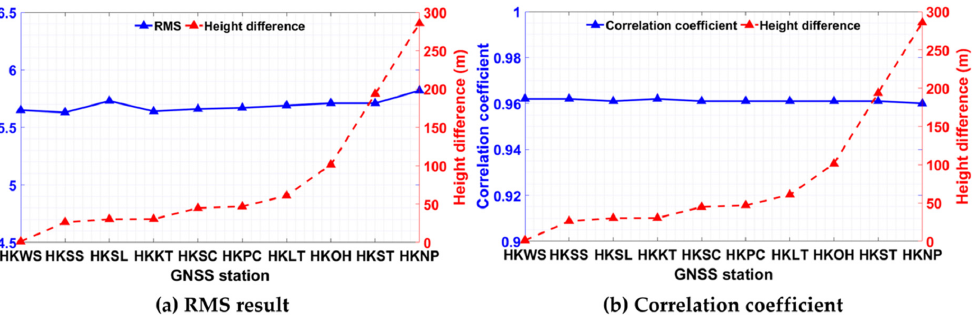
Figure 4. RMS ( a ) and correlation coefficient ( b ) results of calibrated TH-PETs at the KP station using the temperature, pressure, MJD, and ZTD time series (retrieved at ten GNSS stations with different height differences) over the period 2008–2019.